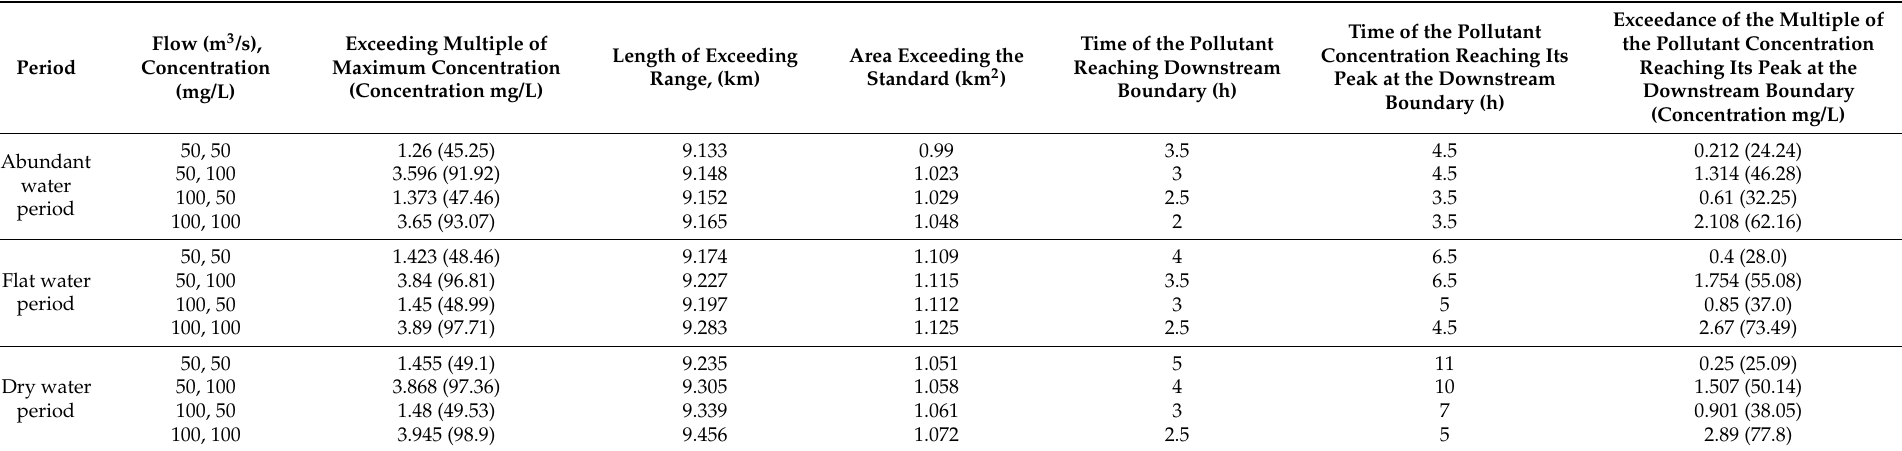
Table 2. COD early warning indicator values in high-flow, level, and low-flow